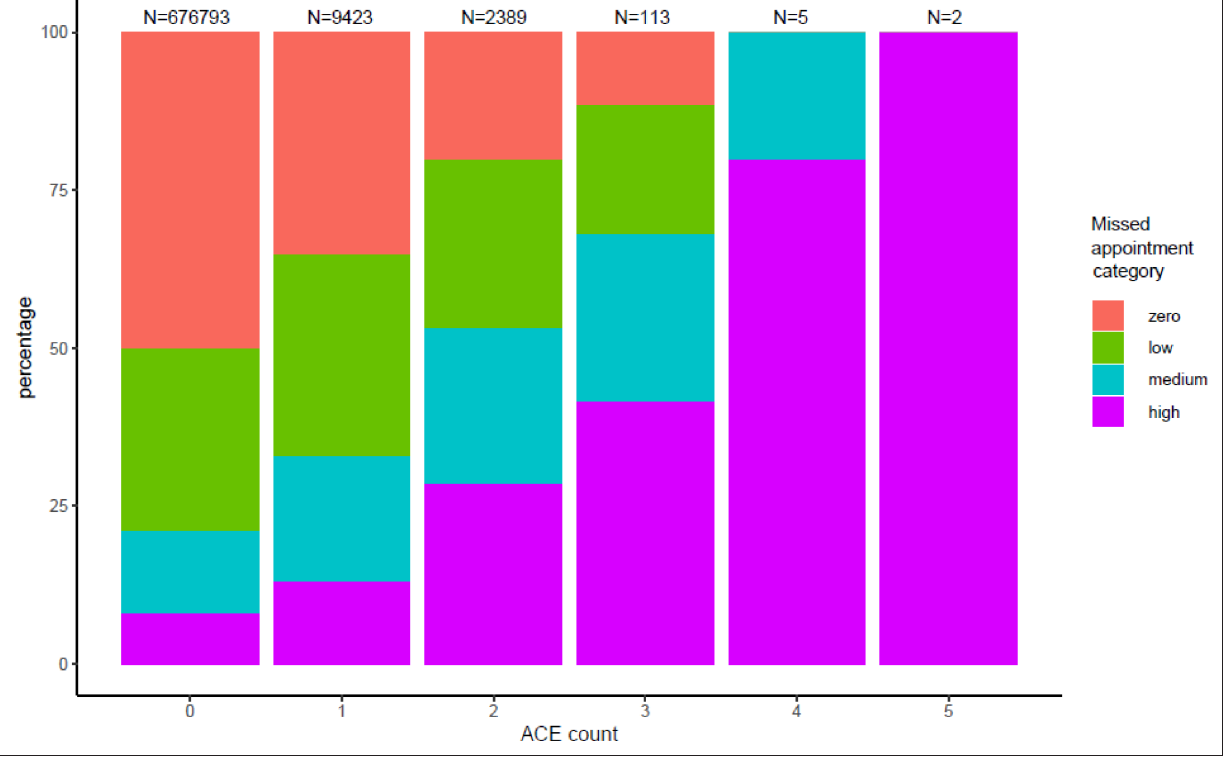
Figure 1 Cumulative ACEs by missed appointment category. ACE = adverse childhood